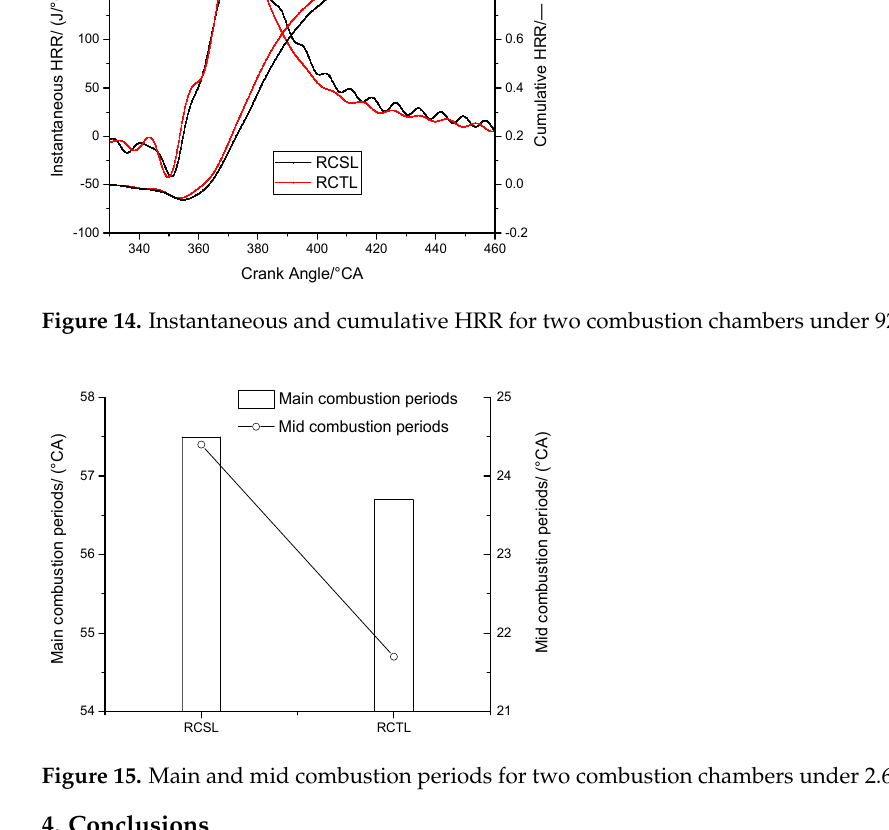
Figure 15. Main and mid combustion periods for two combustion chambers under 2.6 MPa load.